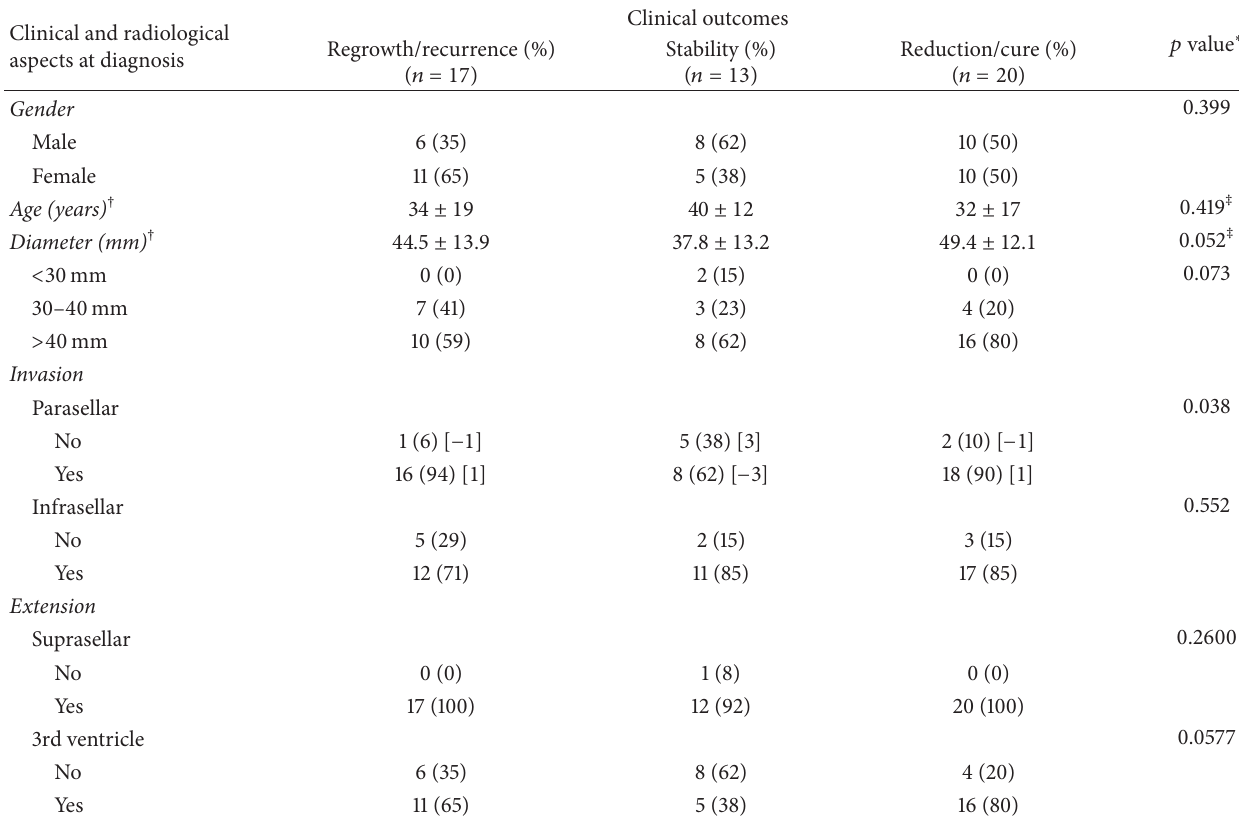
Table 6: Clinical and radiological features and tumor evolution